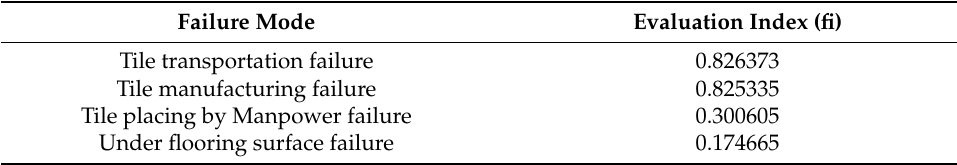
Table 16. Evaluation index for each failure mode after